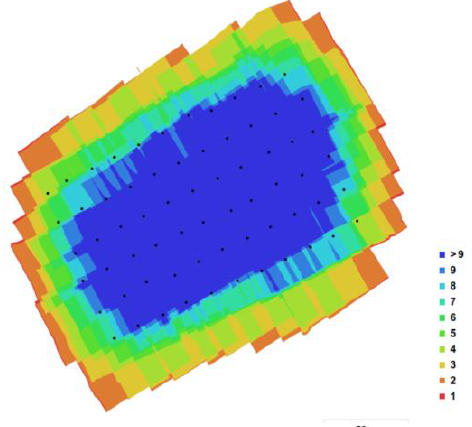
Figure 4. Distribution of waypoints programmed in the flight route and image